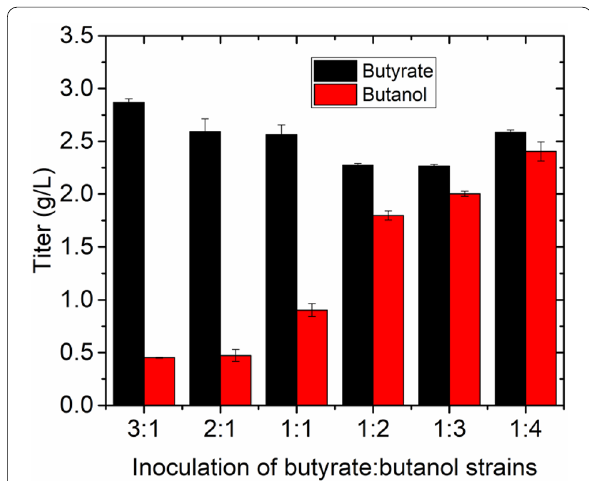
Fig. 3 Production of butyrate and butanol using consortia with varying inoculation ratios of the butyrate- and butanol-producing strains. The titers of butyrate and butanol were measured after 72 h of tube fermentation. The data represent the means biological